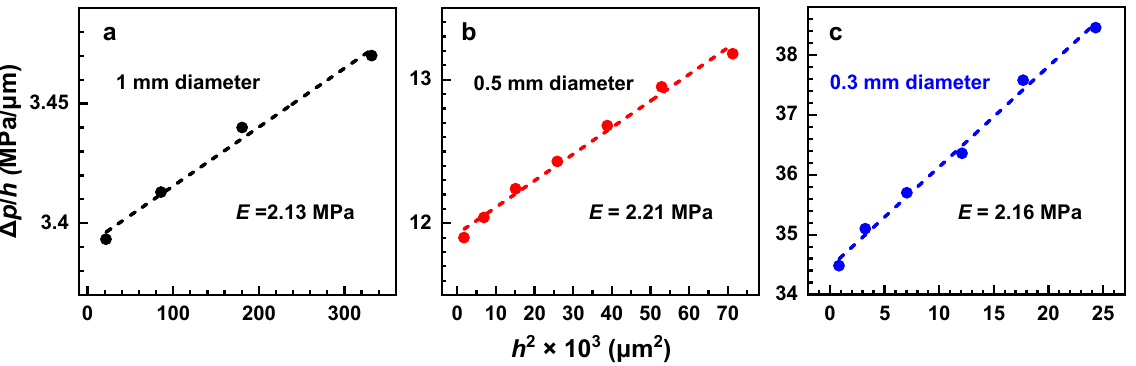
Figure 4. ∆ p / h vs. h 2 plots for the PEG membranes suspended over the circular window with a diameter of 1 mm ( a ), 0.5 mm ( b ), and 0.3 mm ( c ). The straight lines are linear fits to the experimental points. The E values were derived from the slopes of these lines, according to Equation (1).